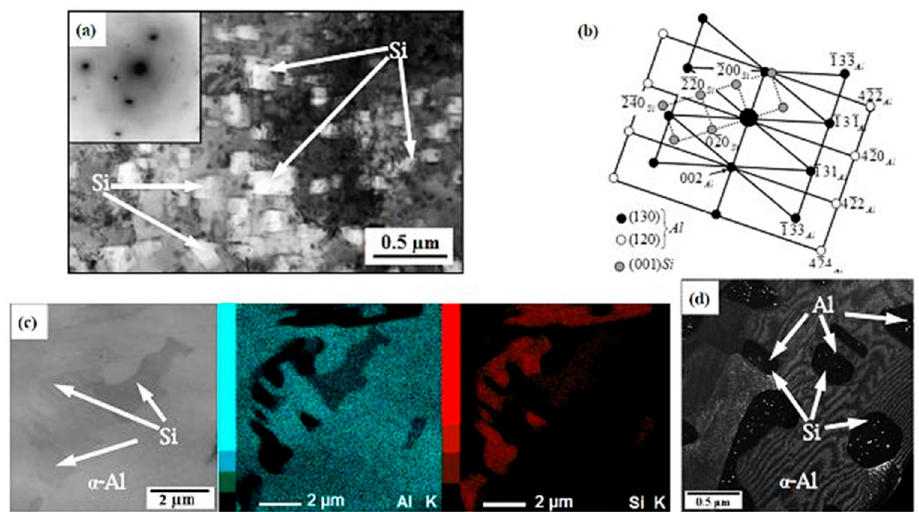
Figure 4. An electron microscope image of the Al-7%Si alloy after the introduction of 0.2 mass. % K 2 ZrF 6 : ( a ) a bright-field image and its microdiffraction pattern; ( b ) reflexes belonging to planes (120) and (130) Al and (001) Si are presented; ( c ) a bright-field image and mapping of the section; ( d ) a dark-field image.